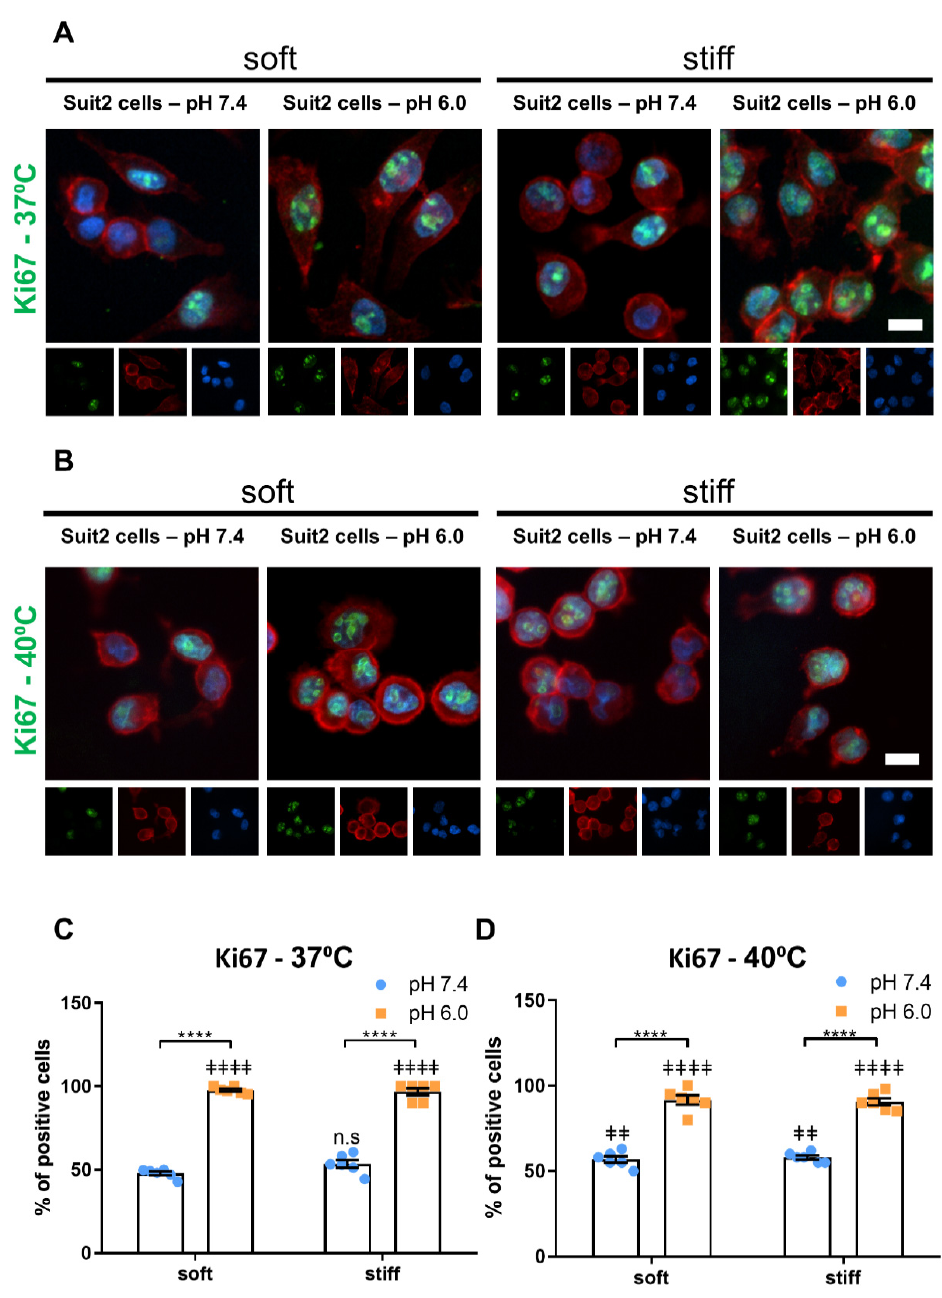
Figure 3. Low, tumor-mimicking pH increased the proliferation of Suit-2 007 cells cultured on soft and stiff self-assembling peptide hydrogels. ( A , B ) Widefield, epifluorescent images of Ki67 as a marker of proliferation for cells cultured on soft (Gamma 2) and stiff (Alpha 2) Manchester BIOGEL PeptiGels in physiologically healthy (7.4) and tumor-mimicking (6.0) pH at 37 °C ( A ) and 40 °C ( B ). Ki67 (green), actin (red) and nucleus (blue). Scale bar represents 50 µm. ( C , D ) Percentage of Ki67 positive nuclei presented in ( A , B ), respectively. Histogram bars represent the mean ± SEM, and dots represent the average percentage of Ki67 positive cells per individual sample, across three experimental replicates. Three experimental replicates. * markers denote a significant difference between bracket-marked groups by t -test, **** p < 0.0001; ‡ markers denote a significant difference from soft pH 7.4 condition by ANOVA with Dunnett’s post hoc test; n.s.–not significant, ‡‡ 0.001 < p < 0.01 and ‡‡‡‡ p < 0.0001.